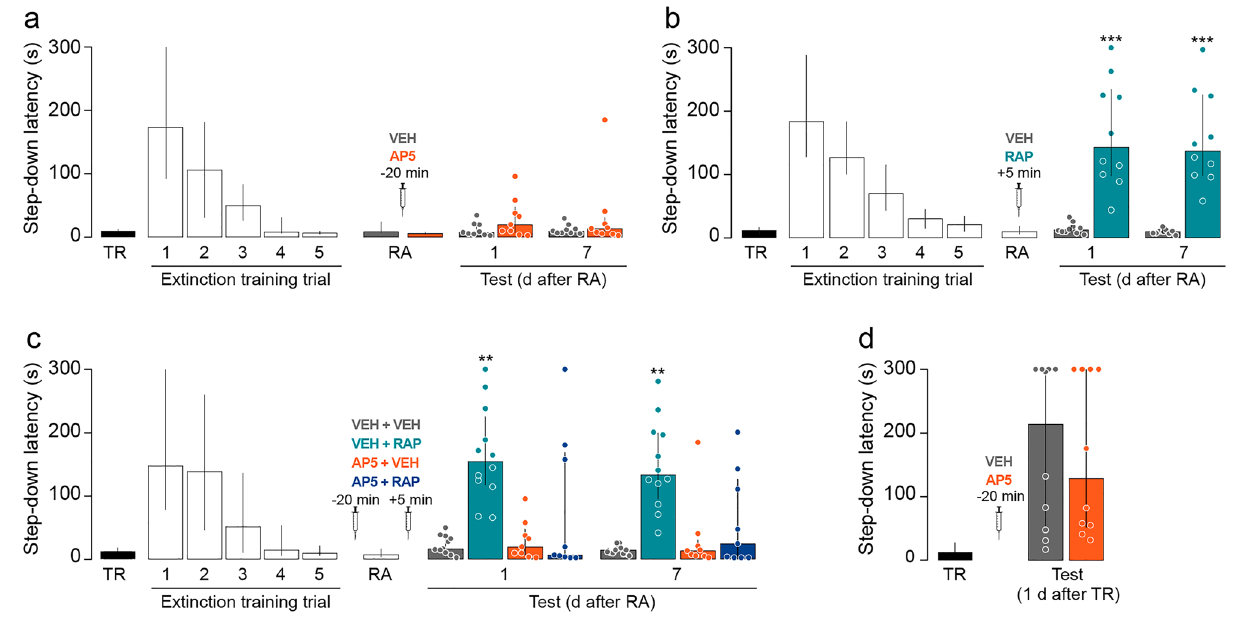
Figure 2. Pre-recall NMDAR blockade does not affect SDIA extinction memory but impedes the amnesic effect of reconsolidation inhibition. ( a ) Animals were trained in SDIA (TR; 0.4 mA/2 s) and beginning 24 h later they were submitted to one daily extinction training trial for 5 consecutive days. One day after the last extinction training trial, animals received bilateral intra-CA1 infusions of vehicle (VEH; 1% DMSO in saline) or the NMDAR antagonist AP5 (5 µg/side), and 20 min thereafter, SDIA extinction memory was reactivated (RA). Retention was assessed 1 day and 7 days later (Test). ( b ) Animals were treated as in A except that they received intra-CA1 infusions of VEH or rapamycin (RAP; 0.02 µg/side), an inhibitor of mammalian target of RAP (mTOR) 5 min after RA. ( c ) Animals were treated as in A and ,5 min after RA, they received bilateral intra-dorsal CA1 infusions of VEH or RAP. ( d ) Animals trained in SDIA received bilateral intra-CA1 infusions of VEH or AP5 one day post-training and, 20 min later, were submitted to a SDIA memory retention test. Data are expressed as median ± IQR. (**) p < 0.01, (***) p < 0.001 versus VEH in Dunn’s multiple comparisons after Kruskal–Wallis test; n = 9–12 animals per